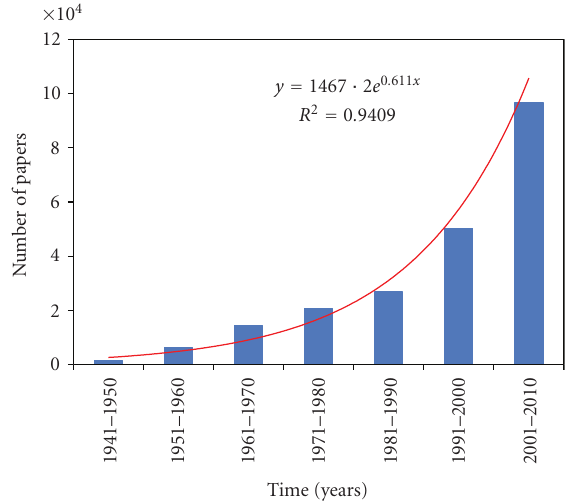
Figure 3: Exponential growth of papers in the area of vaccine and vaccination. The data was obtained by analysis of available papers in